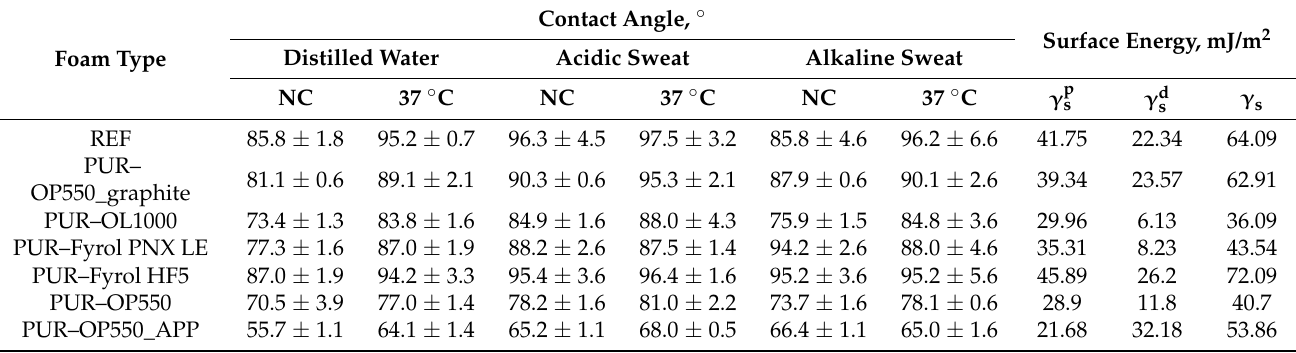
Table 5. Contact angle and surface